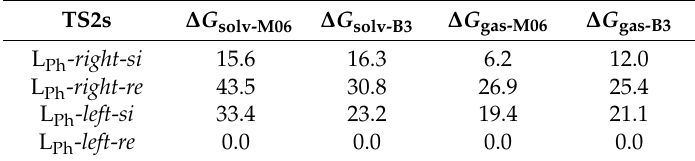
Table 2. ∆ G values of competing TS2 s in the ( S,S )-Ph-BPE system calculated at different levels. TS2s